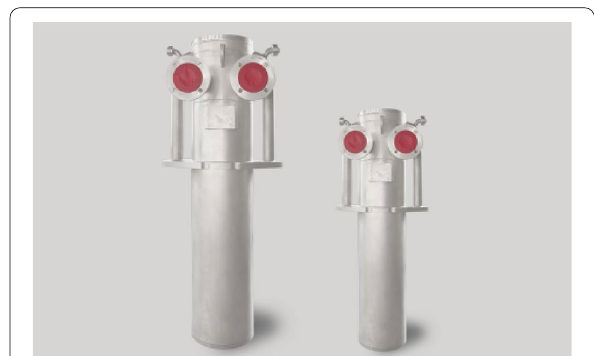
Figure 1 Lubricating-oil cooler